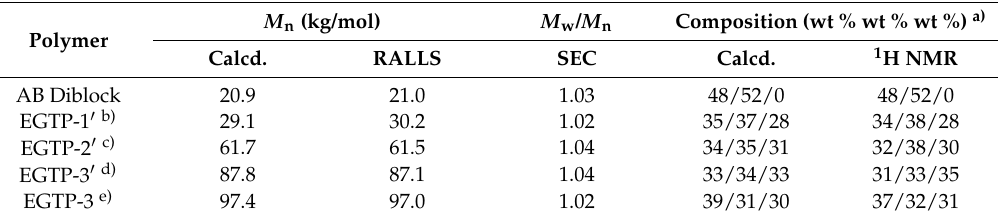
Table 7. Characterization results of EDG terpolymers synthesized by the iterative methodology.